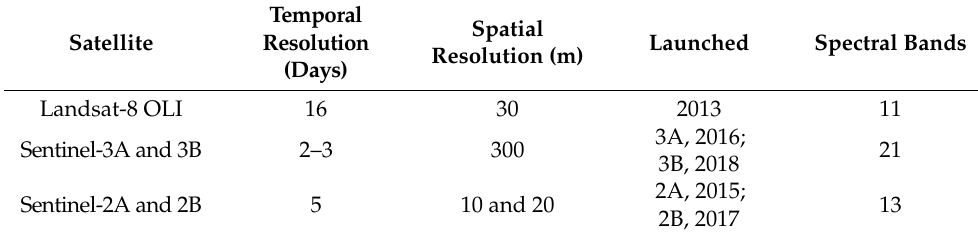
Table 1. Characteristics of the optical sensors used in this study. Temporal Spatial Launched Spectral Bands Satellite Resolution Resolution (m) (Days) Landsat-8 OLI 16 30